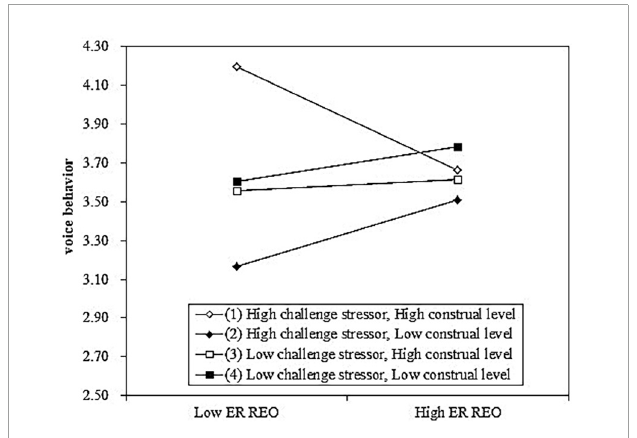
FIGURE2 Results of the three-way interaction in study 2 [employees-organization reciprocal exchange orientation (EO REO) represents employees-organization reciprocal exchange orientation].